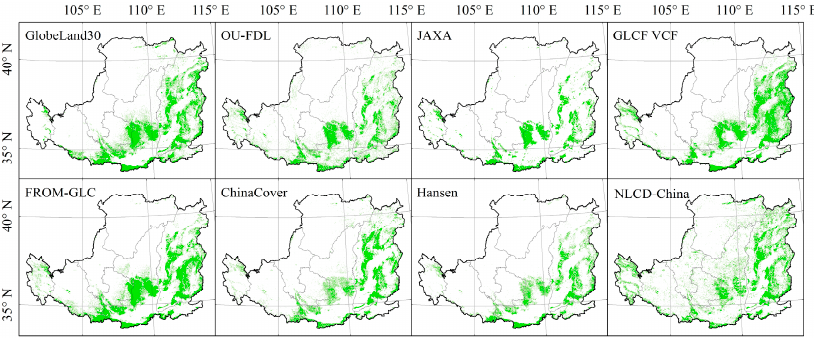
Figure 3. Distribution of forests according to the eight different forest products (GlobeLand30, OU-FDL, Hansen, NLCD-China, FROM-GLC, JAXA, GLCF VCF, and ChinaCover).